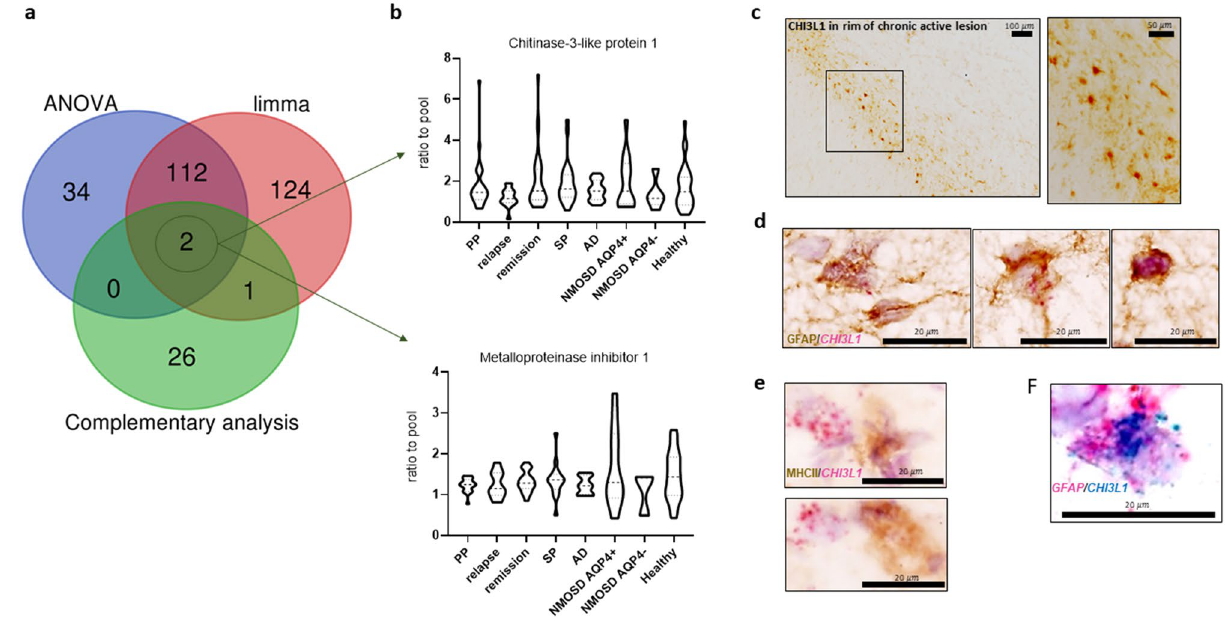
Figure 4. Chitinase-3-like protein 1 (CHI3L1) and metalloproteinase inhibitor 1 (TIMP-1). ( a ) Venn diagram showing the 299 proteins from discovery CSF proteomics significantly altered compared to healthy by different statistical analyses (ANOVA, limma, complementary analysis, see Methods). ( b ) Quantitative levels of chitinase-3-like protein 1 (CHI3L1) and metalloproteinase inhibitor 1 (TIMP-1) in individual CSF samples (detection of CHI3L1: PP = 30 of 30; relapse = 14 of 14; remission = 33 of 33; SP = 26 of 26; AD = 22 of 22; AQP4 + NMOSD = 13 of 13; AQP4 − NMOSD = 5 of 5; healthy = 27 of 27) (detection of TIMP-1: PP = 19 of 30; relapse = 10 of 14; remission = 27 of 33; SP = 16 of 26; AD = 13 of 22; AQP4 + NMOSD = 10 of 13; AQP4 − NMOSD = 3 of 5; healthy = 16 of 27). ( c ) Protein expression of CHI3L1 in the rim of a chronic active lesion of progressive MS brain. ( d ) Protein expression of GFAP (brown) and RNA expression of CHI3L1 (red) in the same cells (combined immunohistochemistry and RNAscope). ( e ) Protein expression of MHCII (brown) and RNA expression of CHI3L1 (red) in different cells close to each other at the rim of the lesion